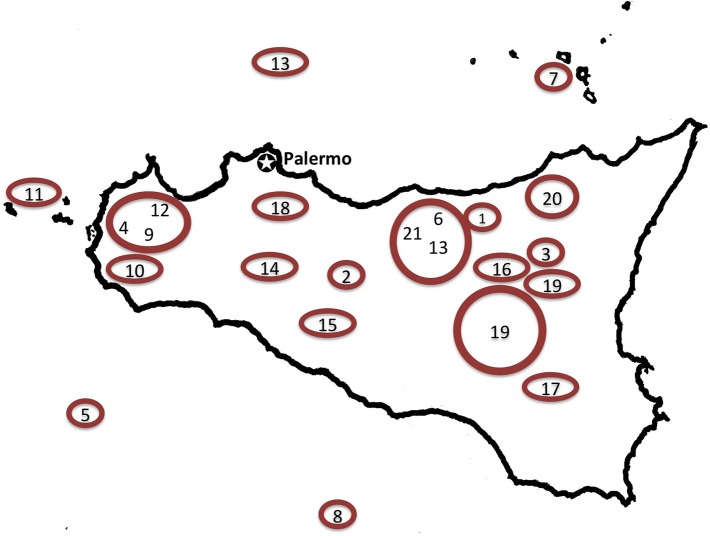
Map of Sicily indicating considered field studies addressing popular medicinal plant use. 1, Mistretta; Messina (Lentini and Raimondo, 1990); 2, Mussomeli; Caltanissetta (Amico and Sorge, 1997); 3, Cesarò; Messina (Barbagallo et al., 1979); 4, Erice; Trapani (Lentini and Aleo, 1991); 5, Pantelleria; Trapani (Galt and Galt, 1978); 6, Madonie, Palermo (Raimondo and Lentini, 1990); 7, Eolie, Messina (Lentini et al., 1995); 8, Pelagie, Agrigento (Lentini et al., 1996); 9, Trapani (Lentini, 1987); 10, Mazara del Vallo; Trapani (Lentini et al., 1987–1988); 11, Egadi; Trapani (Lentini et al., 1997); 12, Riserva Naturale Dello Zingaro; Trapani (Lentini and Mazzola, 1998); 13, Ustica; Palermo (Lentini et al., 1994); 14, Bivona, Agrigento (Catanzaro, 1970); 15, Sant'Angelo Muxaro, Agrigento (Lentini, 1996); 16, Bronte, Catania (Arcidiacono et al., 1999); 17, Monterosso Almo, Ragusa (Napoli and Giglio, 2002); 18, Mezzojuso, Palermo (Ilardi and Raimondo, 1992); 19, Sicilia centro-orientale (Barbagallo et al., 2004); 20, Alcara Li Fusi e Militello Rosmarino, Messina (Arcidiacono et al., 2007); 21, Madonie Regional Park (Leto et al., 2013).